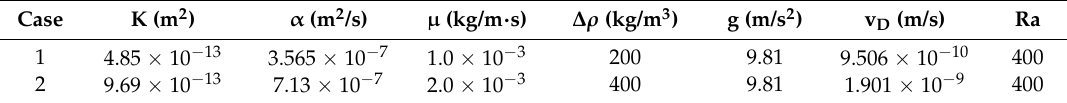
Table 3. Physical parameters of the second application.